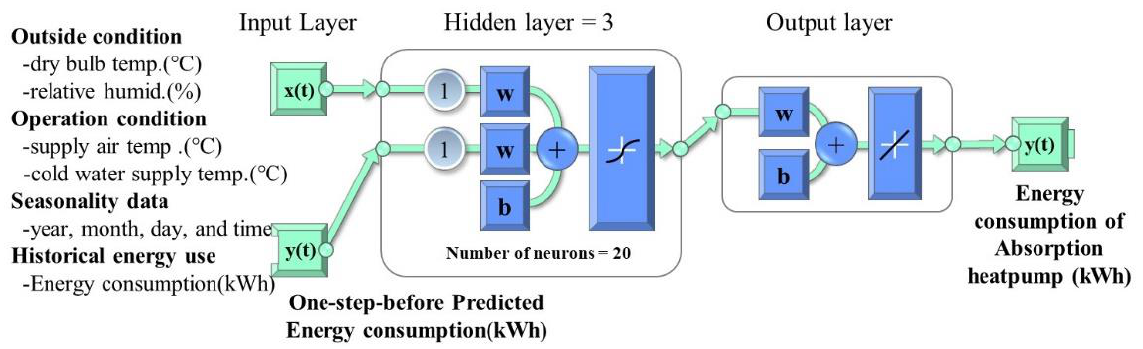
Figure 2. Schematic of the multilayer shallow neural network training algorithms for predicting energy consumption.